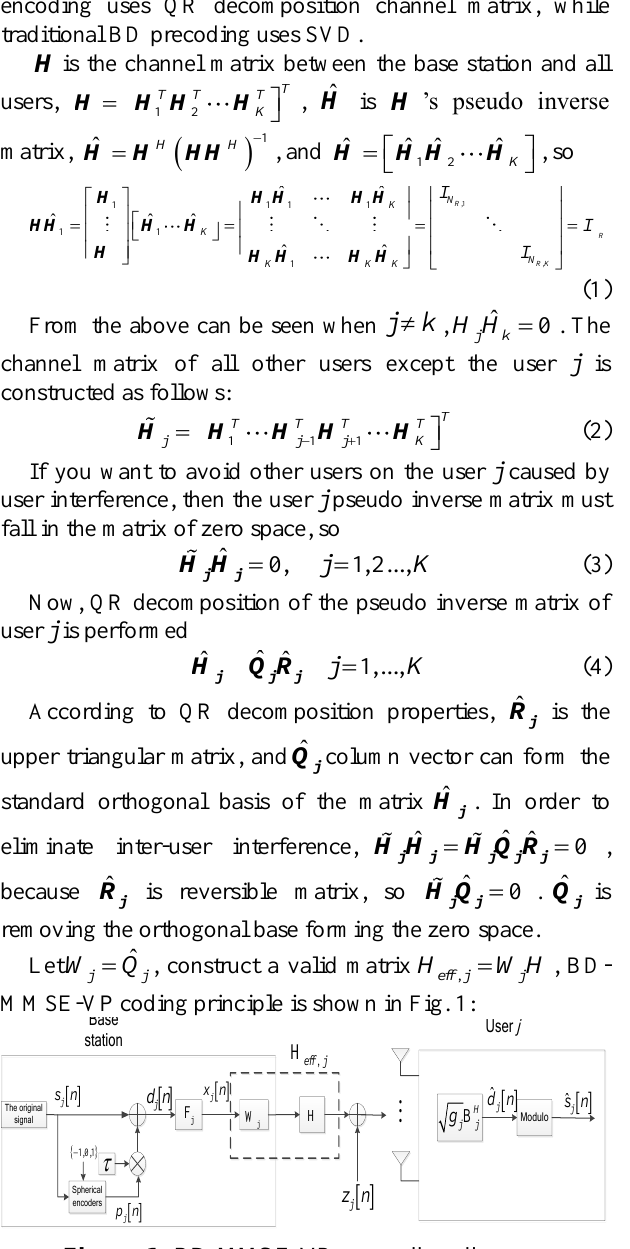
Figure 1. BD-MMSE-VP precoding diagram The optimal perturbation vector and power constraint factor are found by using MMSE criterion,   j wants to get the